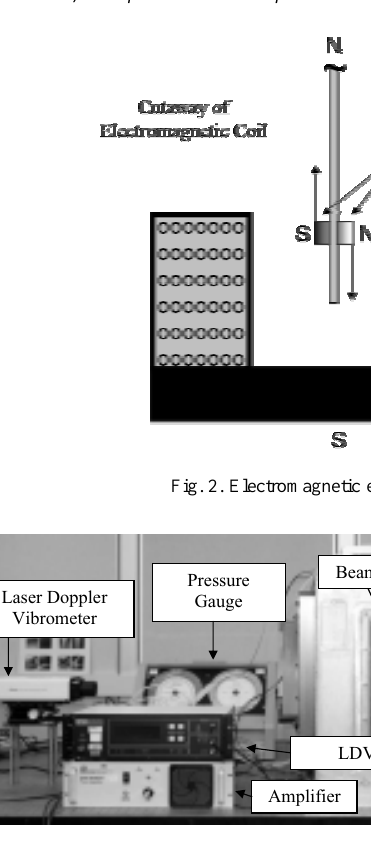
Fig. 3. Overview of experimental